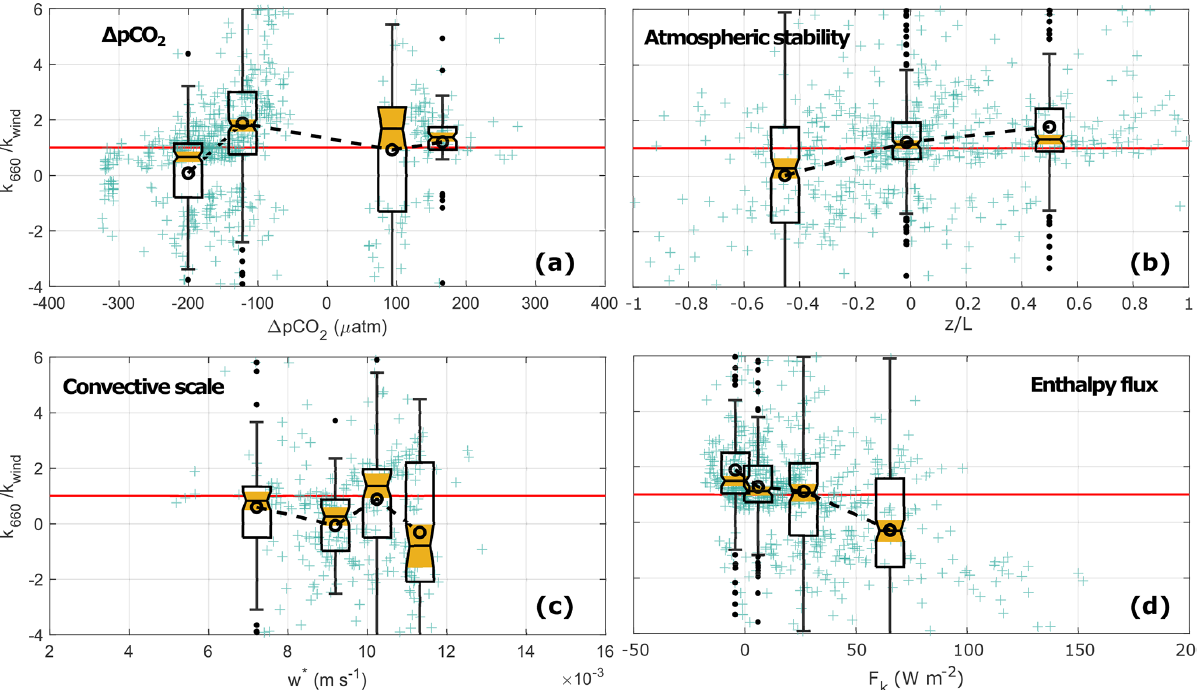
Figure 8. Normalized gas transfer velocity ( k 660 /k wind ) under low-wind-speed conditions ( U 10N ≤ 6ms − 1 ) as a function of (a) (cid:49)p CO 2 , (b) atmospheric stability ( z/L ), (c) the water-side convective scale ( w ∗ ) under unstable atmospheric conditions, and (d) enthalpy flux ( F k ). The crosses represent the individual half-hourly values. The boxplots give a statistical summary for equidensity bins defined based on the distribution of k 660 /k wind as a function of each of the parameters (see Appendix A). The median, first, and third quartiles are represented in each box; the whiskers represent the minimum and maximum values, and the black dots represent the outliers; the notches highlighted in yellow indicate the median’s 95% confidence interval. The open circles linked with a dashed line indicate the bin means, and the horizontal red line indicates k 660 /k wind =